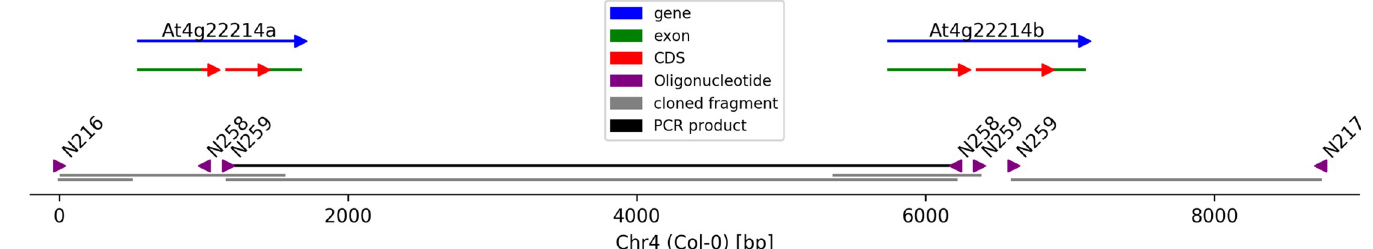
Fig 4. Hidden locus in the Col-0 reference sequence. Differences between the Nd-1 and Col-0 genome sequences lead to the discovery of a collapsed region in the Col- 0 gold standard sequence. There are two copies of At4g22214 (blue) present in the Col-0 genome, while only one copy is represented in the Col-0 gold standard sequence. This gene duplication was initially validated through PCR with outwards facing oligonucleotides N258 and N259 (purple) which lead to the formation of the expected PCR product (black). Parts of this region were cloned into plasmids (grey) for sequencing. Sanger and paired-end Illumina sequencing reads revealed one complete gene (At4g22214b) and a degenerated copy (At4g22214a). Moreover, the region downstream of the complete gene copy in Nd-1 indicates the presence of at least one additional degenerated copy.